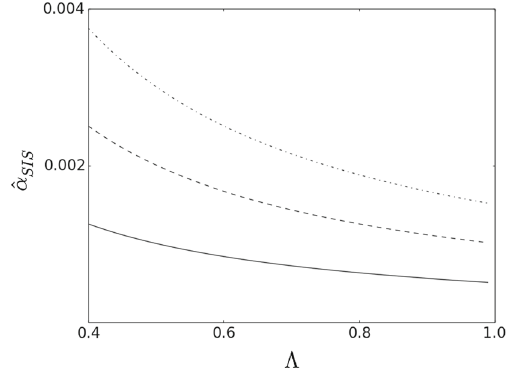
Fig. 6 Plot of ˆ α SIS vs. Λ for (cid:22) J r = 0 . 1 (continuous line), (cid:22) J r = 0 . 2 (dashed line), and (cid:22) J = 0 . 3 (dot-dashed line). We used, b = 10, sin χ = 1, and ω 2 c /ω 2 = 0 . 5